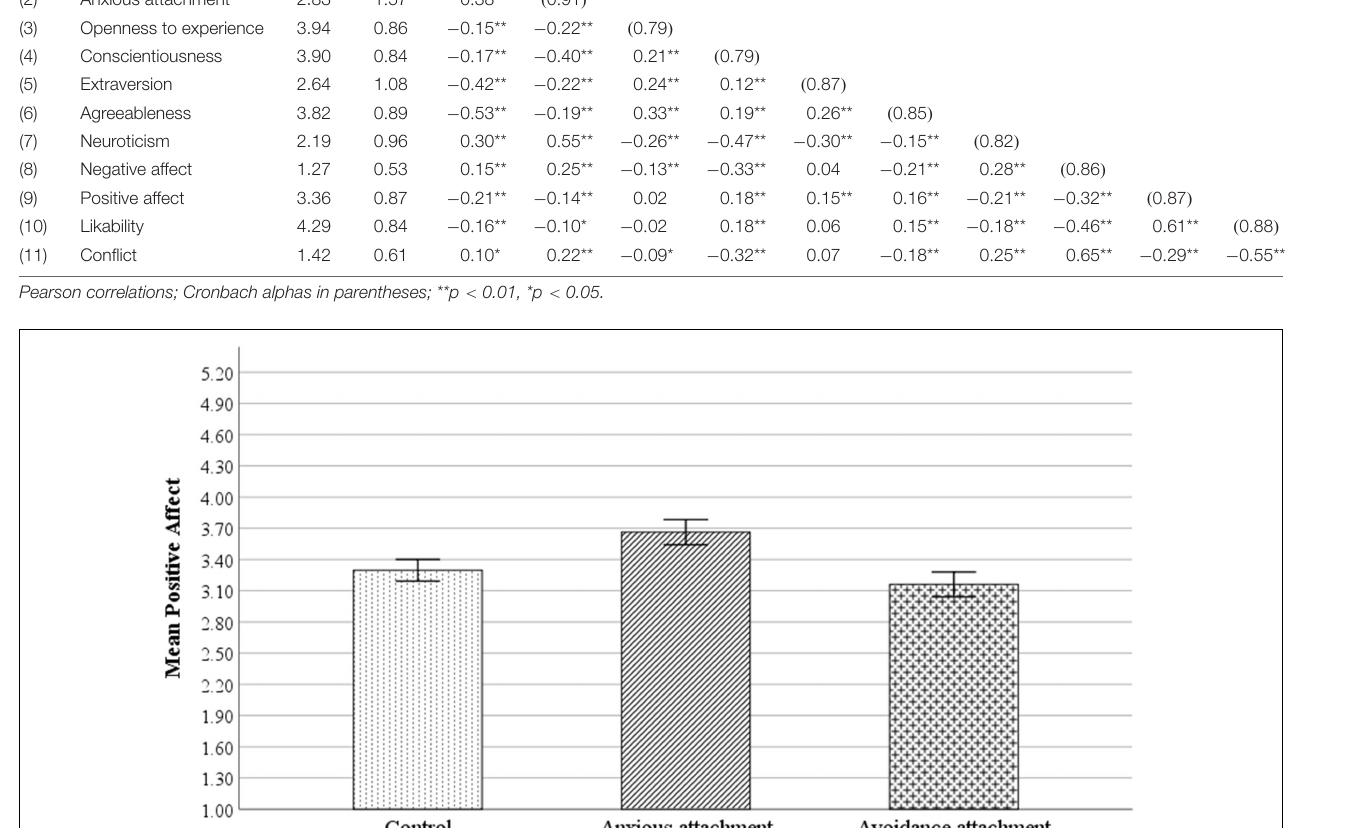
A similar pattern of findings is observed when testing the influence of attachment orientation (anxiety vs. avoidance